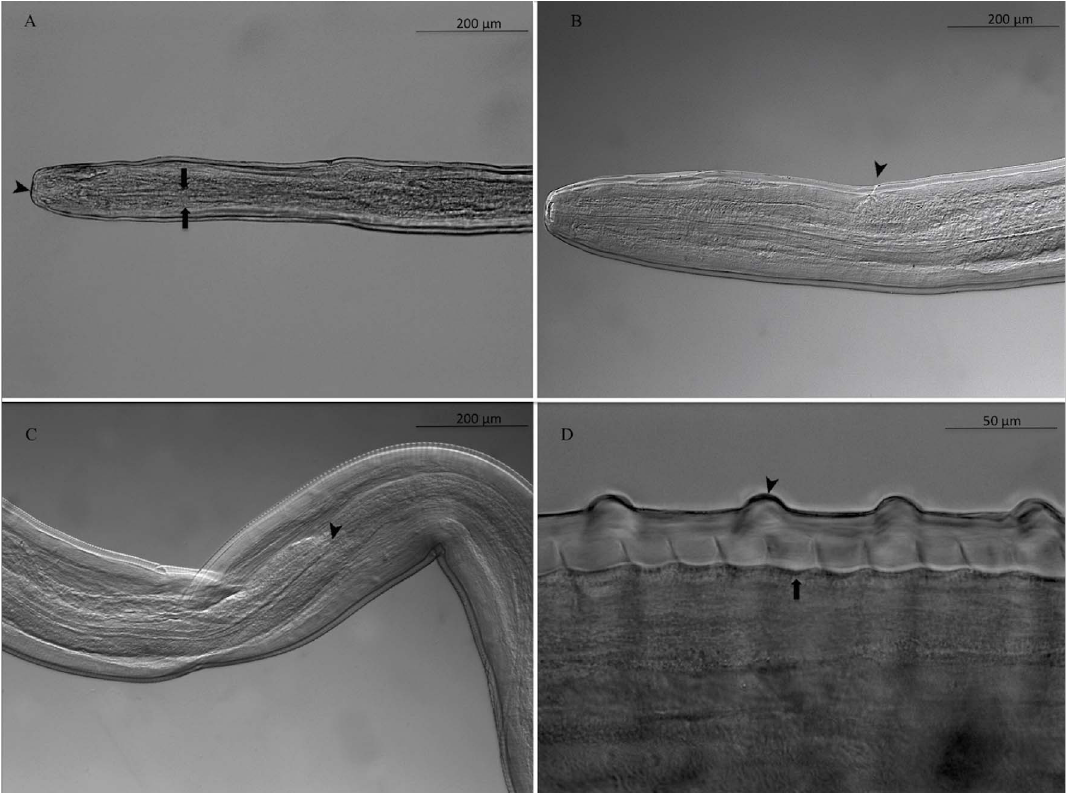
Figure 1. Adult female of Onchocerca fasciata . A. cephalic extremity in lateral view. The minute mouth orifice (arrowhead) and muscular esophagus (arrow). B. Vulvar opening (arrowhead). C. Esophago-intestinal junction (arrowhead). D. Mid-body region of the striated cuticle bearing annular transverse external ridges (arrowhead) and internal striae (arrow).